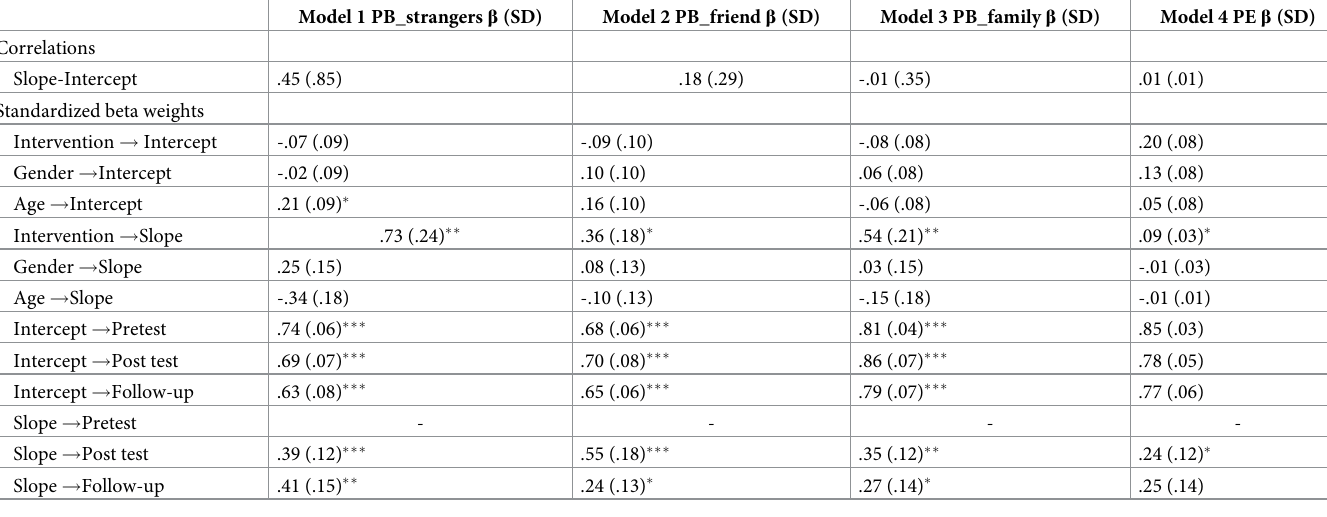
Table 3. Latent growth curve models.